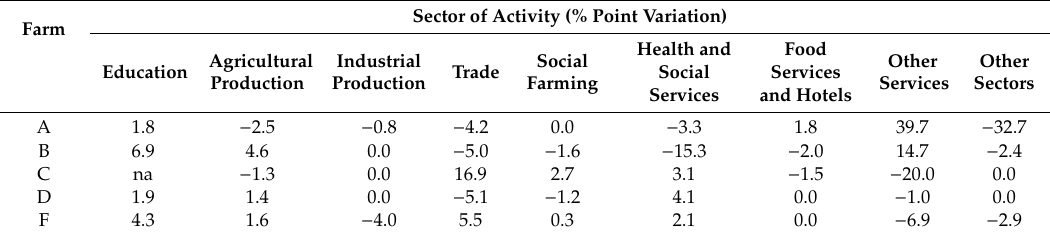
Table 7. Variation (expressed as percentage points) over time (T0 − T1) in the sector of activity of the network